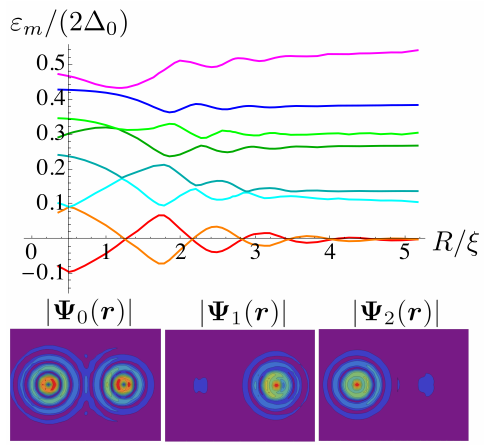
Figure 6: Same as Fig. 2 with one vortex replaced by a hole. In the wavefunction colour maps, shown here for R /ξ = 5.0, the (lowest positive energy) state Ψ is 0 equally weighted between the vortex and the hole, Ψ is mainly localized in the hole 1 (to the right) and Ψ is mainly localized in the vortex (to the left). 2